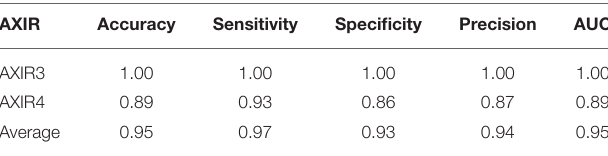
TABLE 8 | Classification performance of AXIR3 (COVID-19/TB) and AXIR4 (COVID-19/non-TB). AXIR